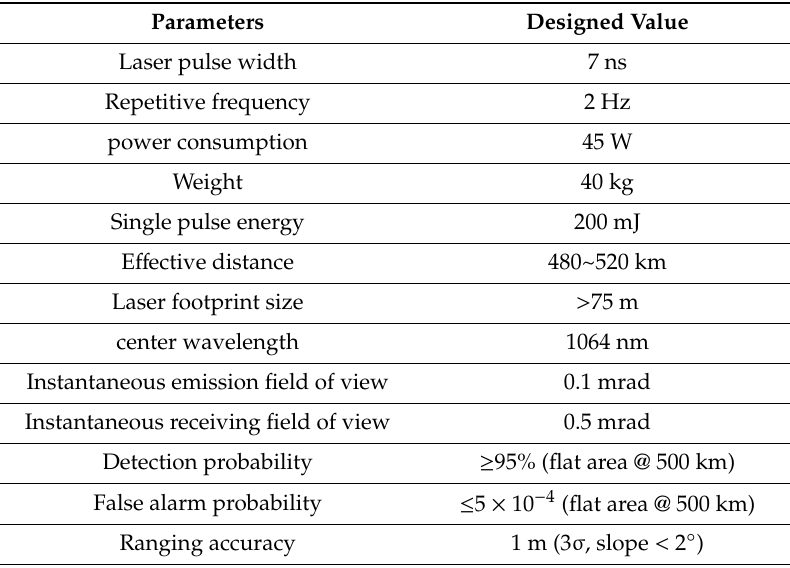
Table 1. Design parameters for the laser altimeter onboard ZY3-02.